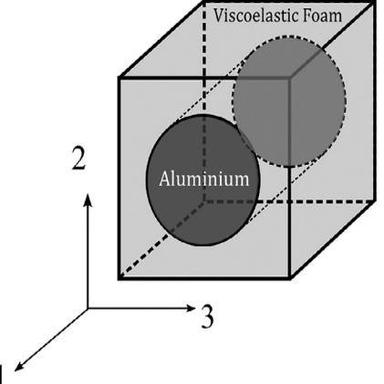
Periodic Unit Cell of the Metamaterial with matrix of melamine foam and cylindrical inclusions of Aluminium.